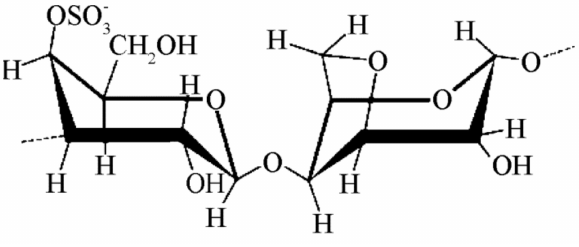
Figure 7. Schematic representation of a κ -carrageenan